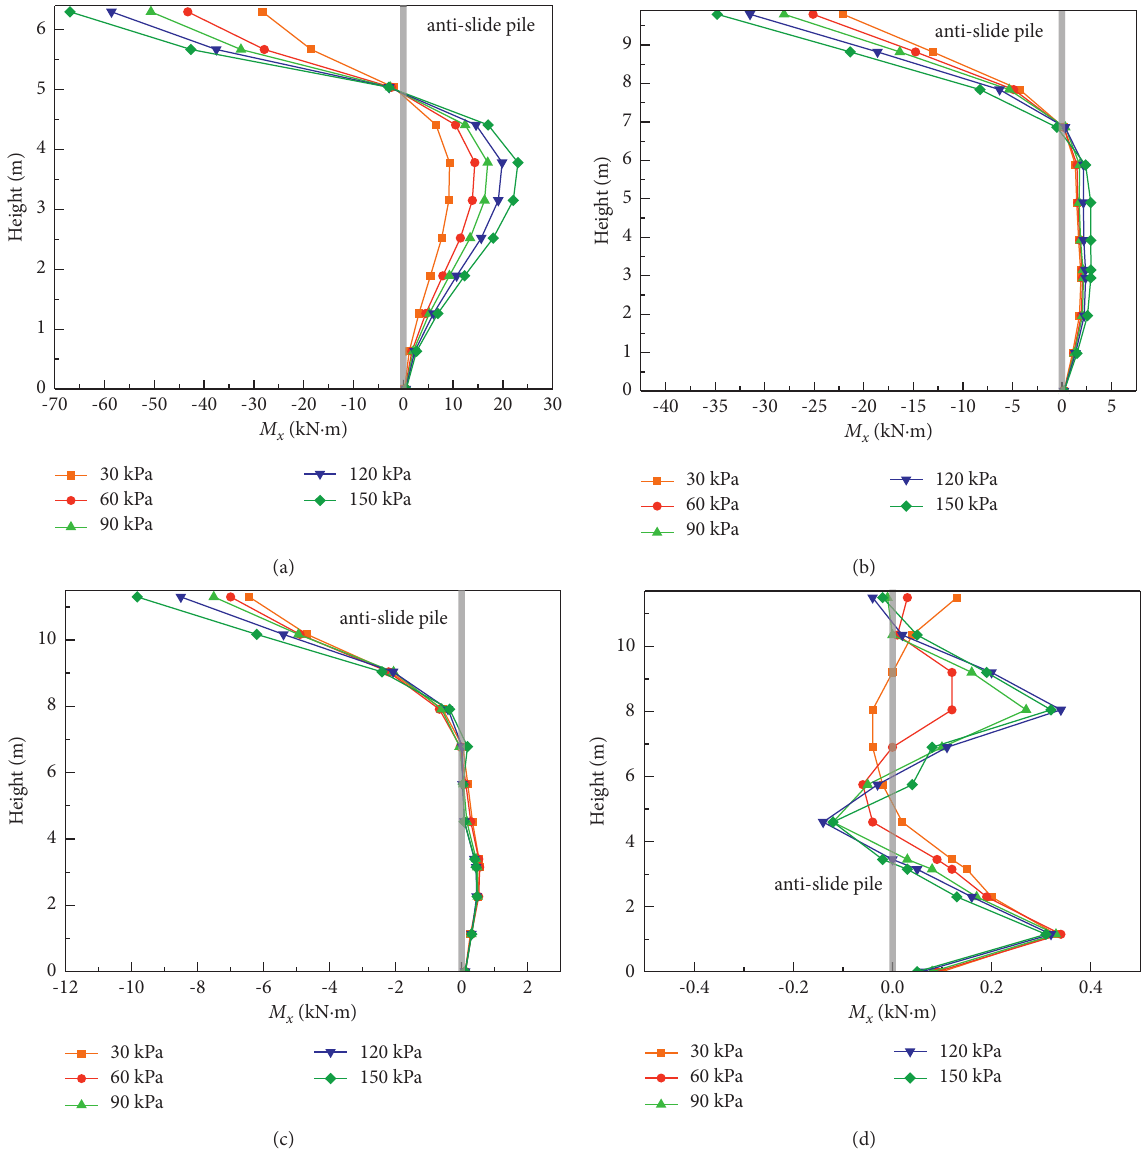
Figure 6: M x (3-16): (a) P1; (b) P3; (c) P5; (d)